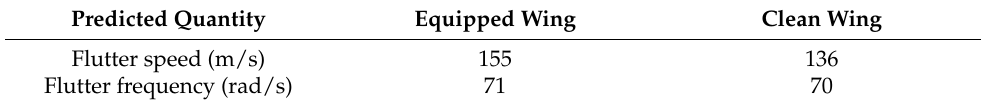
Table 2. Flutter speed and frequency of the wing with and without the effect of the engines. Predicted Quantity Equipped Wing Clean Wing Flutter speed (m/s)